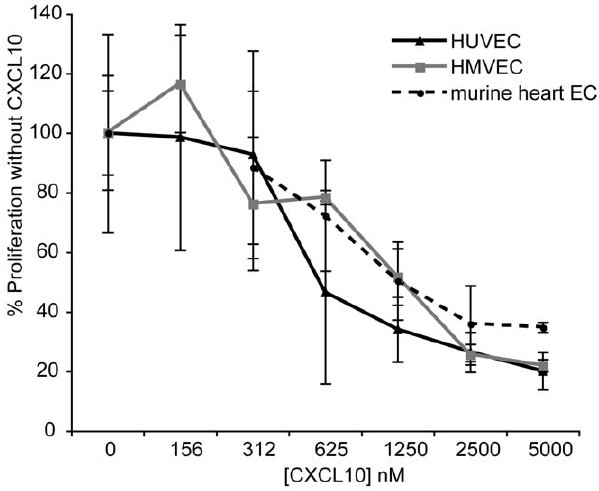
Figure 1. CXCL10 inhibits proliferation of endothelial cells isolated from different organs. Human umbilical cord vein endothelial cells (HUVEC), human lung microvascular endothelial cells (HMVEC-L), and murine heart endothelial cells isolated from C57Bl/6 mice were plated in 96-well plates with bFGF. 24 hr after seeding, new media with CXCL10 was added and replaced every 48 hr for a total of 3–4 days. 3 H-thymidine incorporation was assessed for the final 18 hr of incubation. Representative data of at least three experiments are shown, each performed in triplicate, data are mean 6 SD.